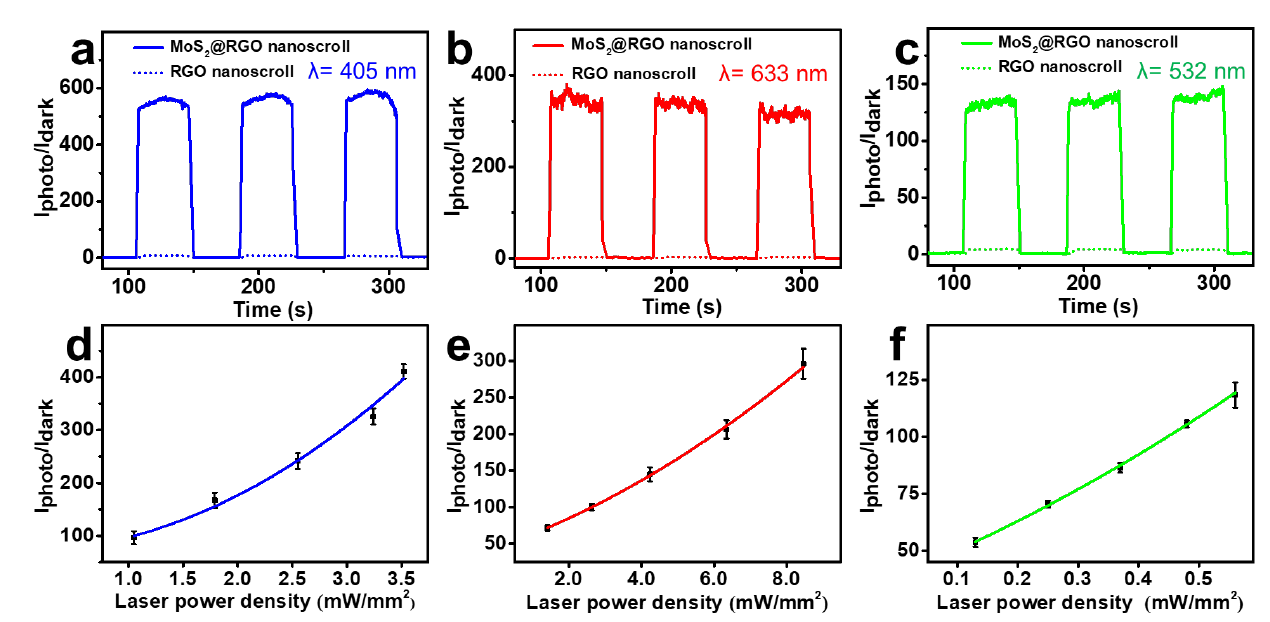
Figure 4. ( a – c ) The PDRs of photodetectors based on RGO and MoS 2 @RGO nanoscrolls under ( a ) blue, ( b ) red and ( c ) green lasers. ( d – f ) Plots of PDR values of photodetectors based on MoS 2 @RGO nanoscrolls under ( d ) blue, ( e ) red and ( f ) green lasers as a function of power density.